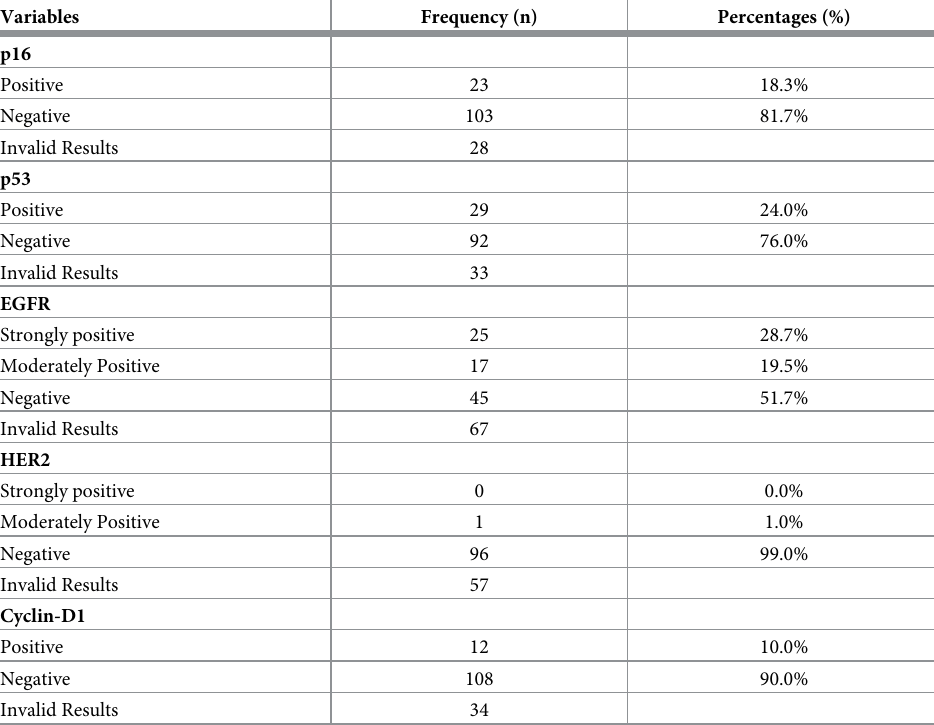
Table 2. Frequency distribution of molecular markers expression of non-oropharyngeal HNSCC patients (n =